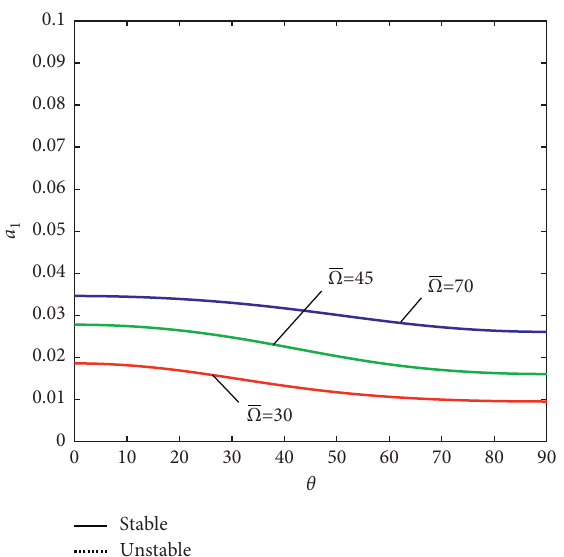
Figure 19: Amplitude versus ply angle with different rotating speeds (L/d � 10, c � 0.01, σ � 2, case I).